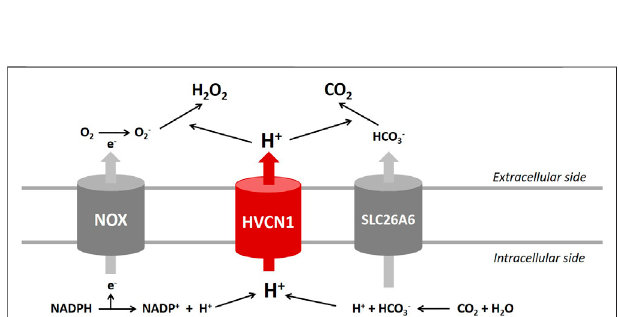
FIGURE 7 | Proposed roles of HVCN1 in regulating pH homeostasis in the heart. Proton (H + ) extrusion by the HVCN1 channel compensates for the electrogenic activity of NOX and regulates the ef fi cient generation of H 2 O 2 . In addition, HVCN1-mediated H + current is associated with transport- mediated CO 2 disposal. Except for HVCN1 functional regulation of pH homeostasis, the present study revealed that HVCN1 regulated the genetic expression of NOXs and SLC26A6 in the